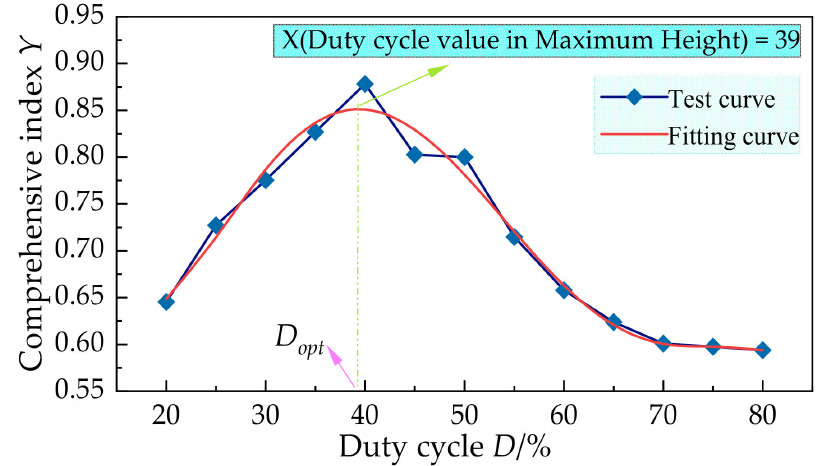
Figure 7. Fitting curve of test results under the condition n t 2 - δ t 2 - ω t 2 - m t 2